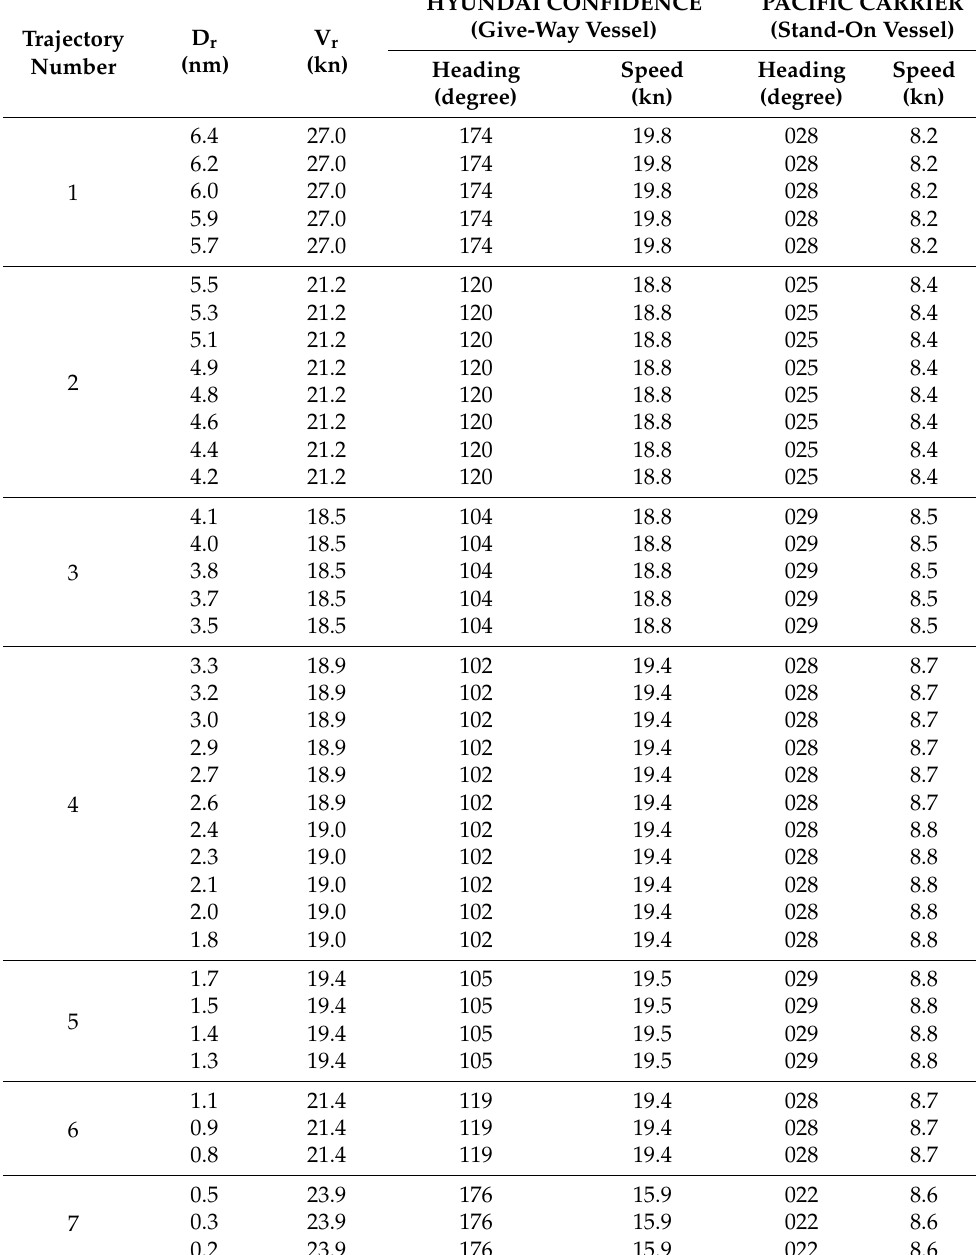
Table 4. AIS trajectory data between HYUNDAI CONFIDENCE and PACIFIC